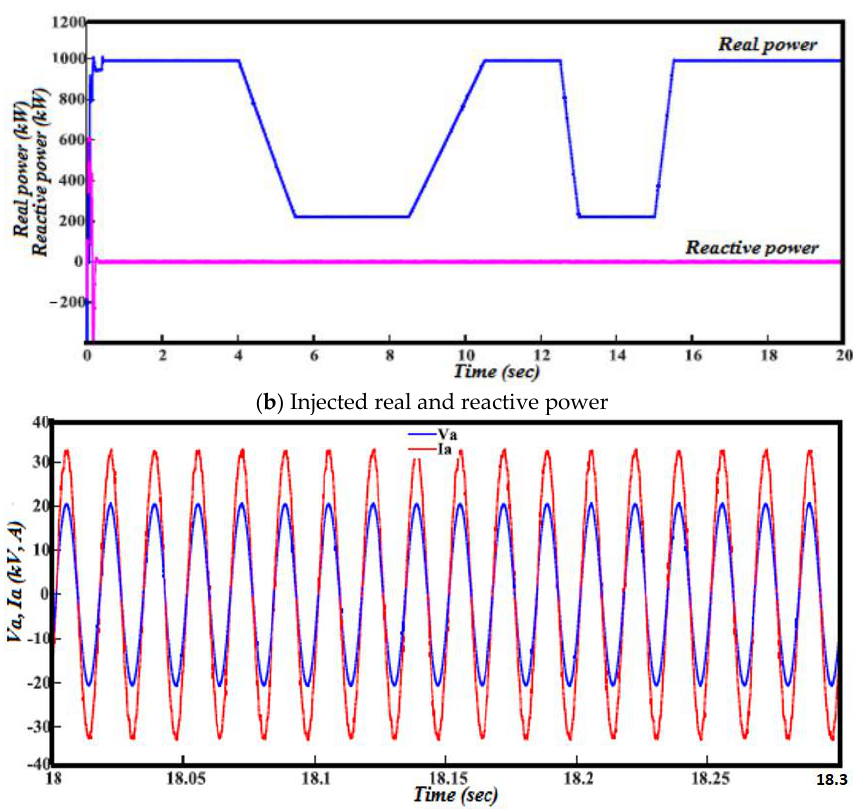
Figure 15. System performance of the PV.